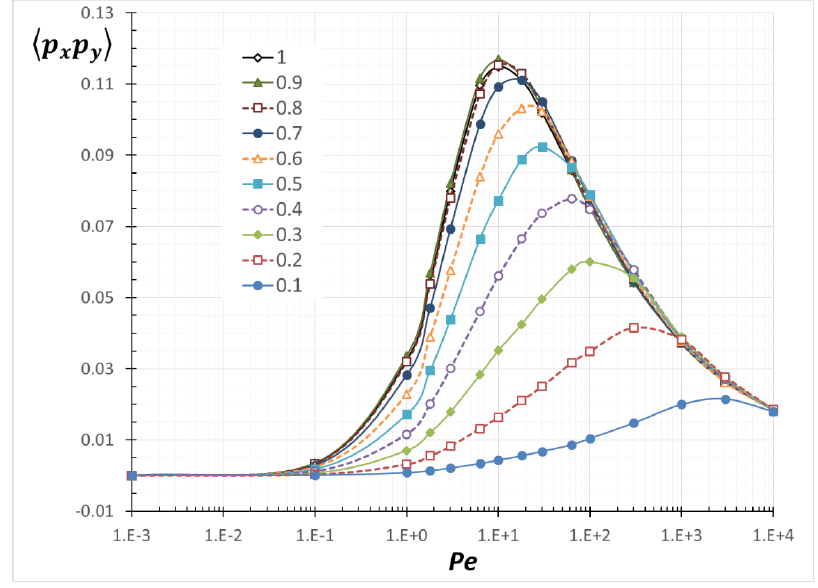
Figure 13. Average orientation moment < p x p y > as a function of Pe with various α / a .